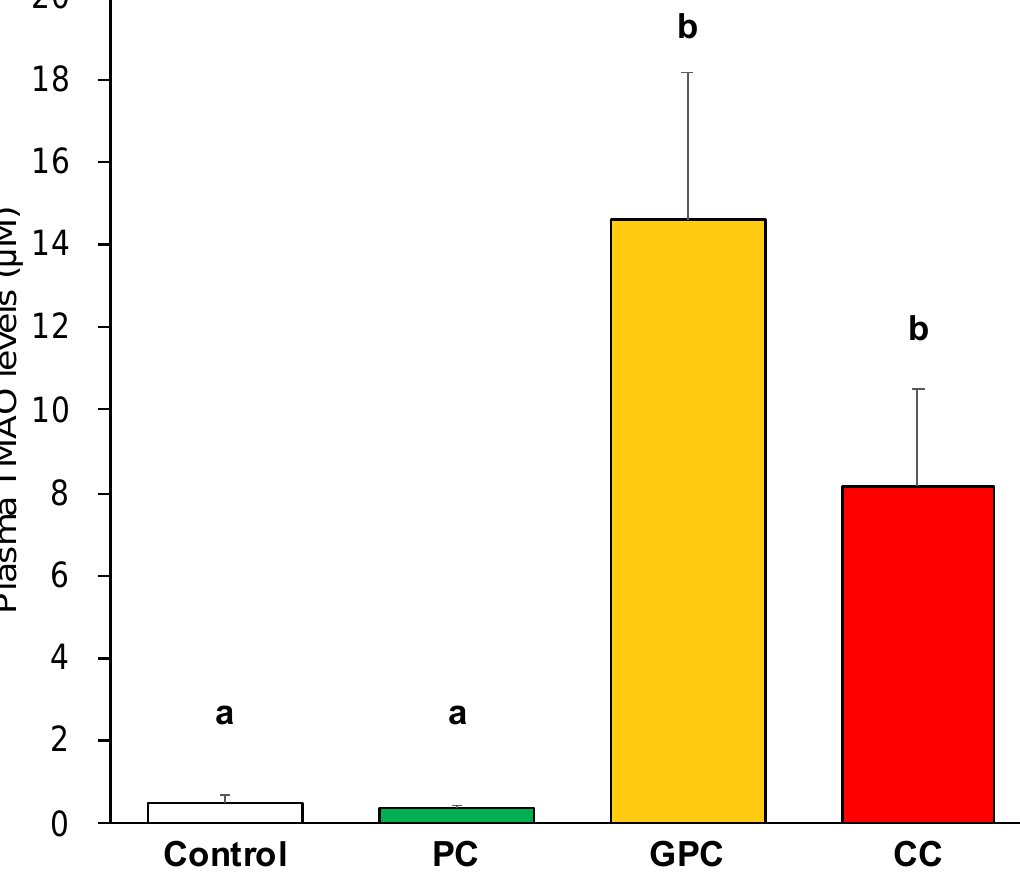
Figure 2. Effects of dietary choline compounds on plasma TMAO levels in rats. Values are expressed as means ± SEM ( n = 5 per group). a,b Different letters show significant differences at p < 0.05 using one-way ANOVA followed by Tukey–Kramer multiple comparison post hoc